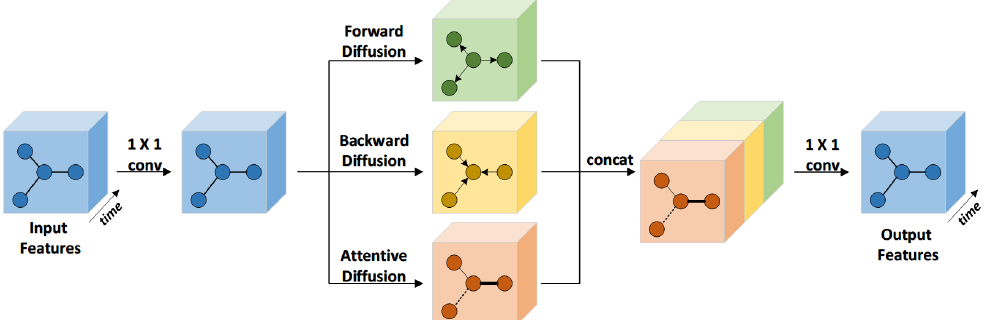
Figure 3. The schematic illustrations of the Multi-Diffusion Convolution (MDC) block. We employ a 1 × 1 convolution to increase the traffic graph signals’ feature dimensions and apply multi-diffusion convolution with forward, backward, and attentive channel, respectively. Then the different spatial features are concatenated together and another 1 × 1 convolution is used to resize features to